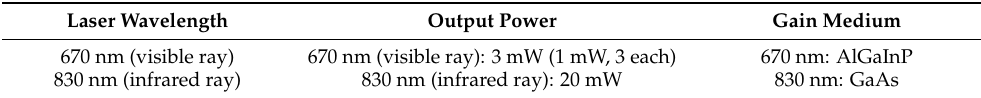
Figure 1. Device for the intranasal laser irradiation (Optowell ® , Jeonju, Korea). The device was applied intranasally for laser irradiation. Table 1. Laser specifications used in low-level laser therapy.